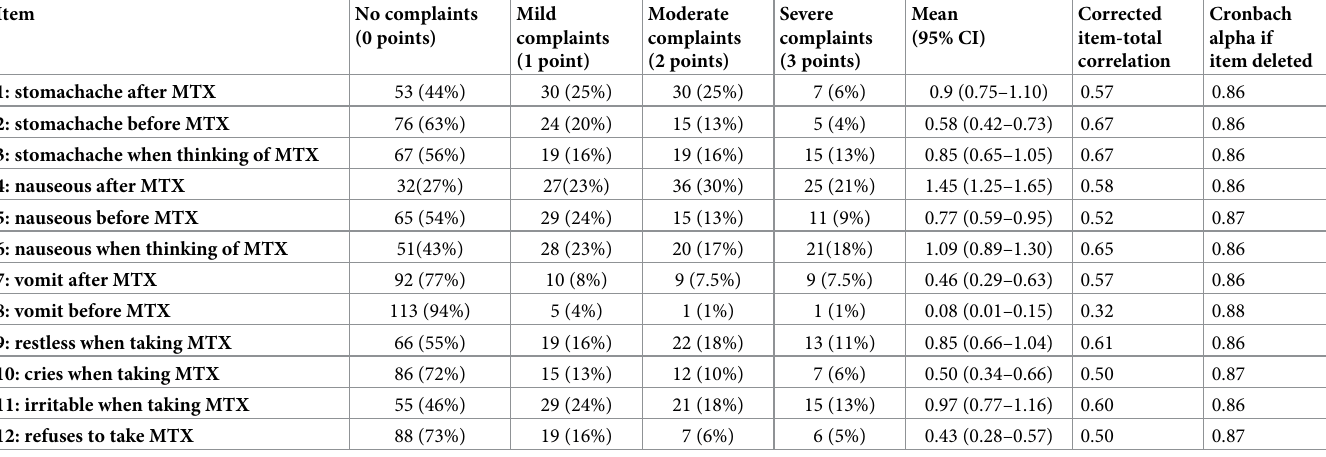
The analysis of internal consistency of the Danish version of the methotrexate intolerance severity score (MISS) for the juvenile idiopathic arthritis group (n = 120),